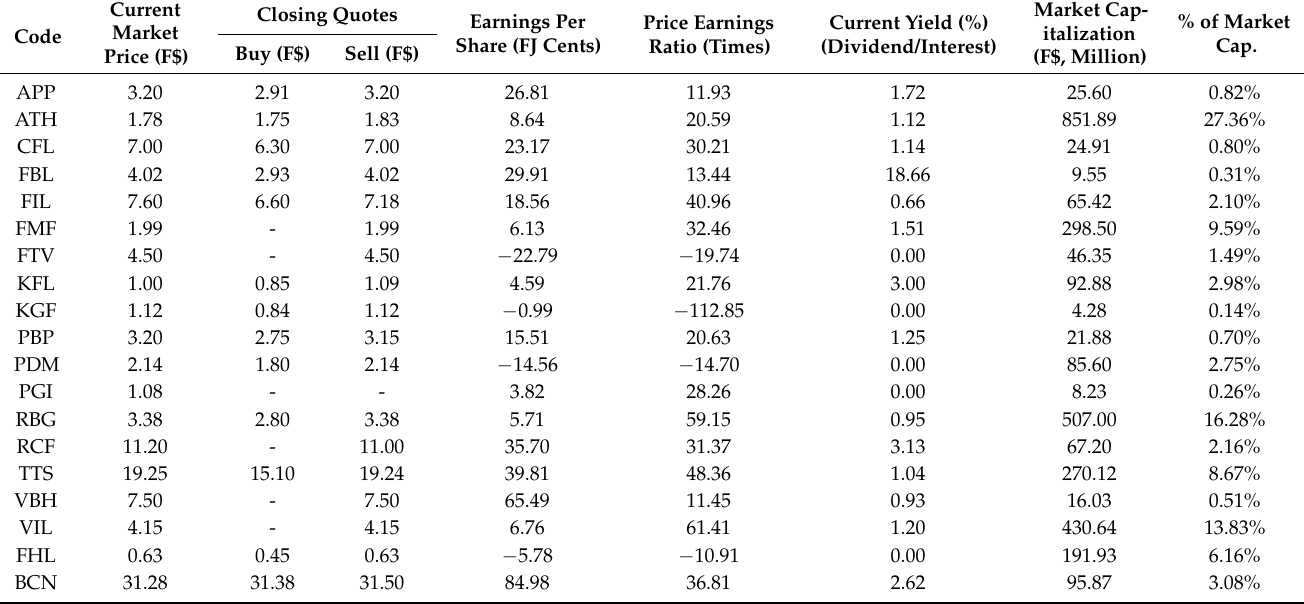
Table 2. SPX Daily